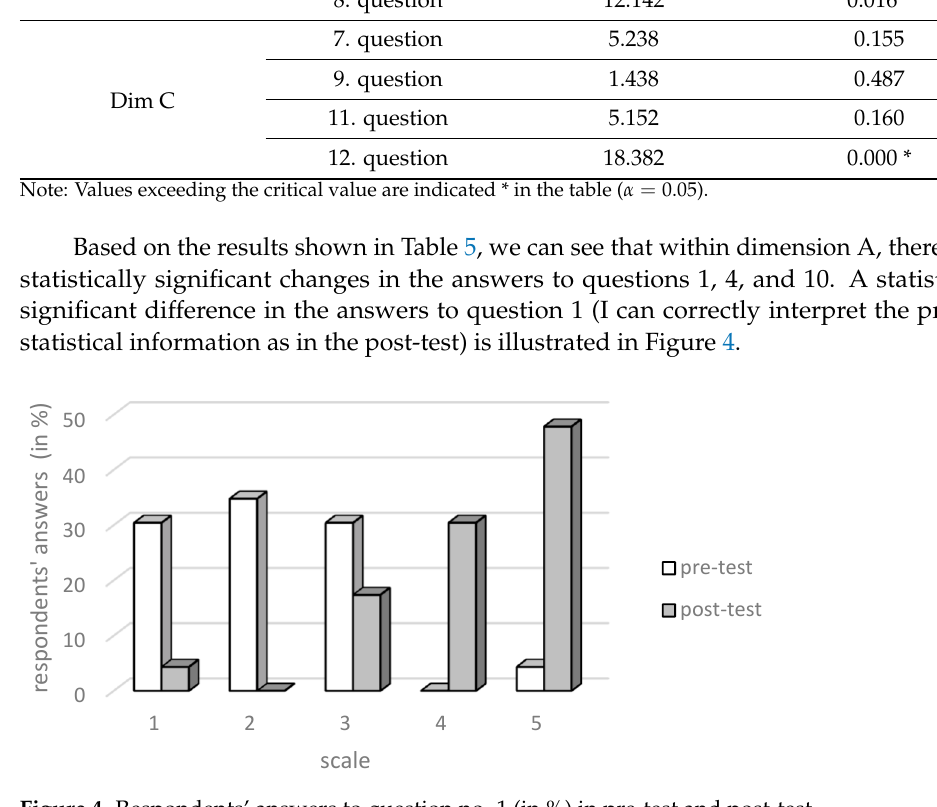
Table 5. Test results (pre-test and post-test).